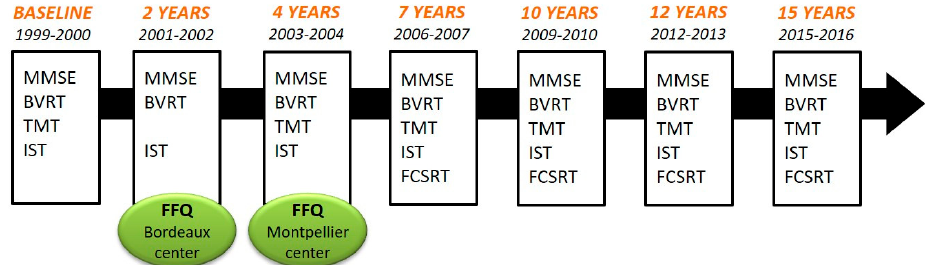
Figure 1. Time frame of the three-city study. Neuropsychological evaluations and dementia diagnoses were made at each follow-up visit. Participants completed the FFQ at the 2-year follow-up visit (Bordeaux center) or at the 4-year follow-up visit (Montpellier center). BVRT, Benton Visual Retention Test; FCSRT, Free and Cued Selective Reminding Test; FFQ, Food Frequency Questionnaire; IST, Isaacs Set Test; MMSE, Mini Mental State Examination; TMT, Trail Making Test.